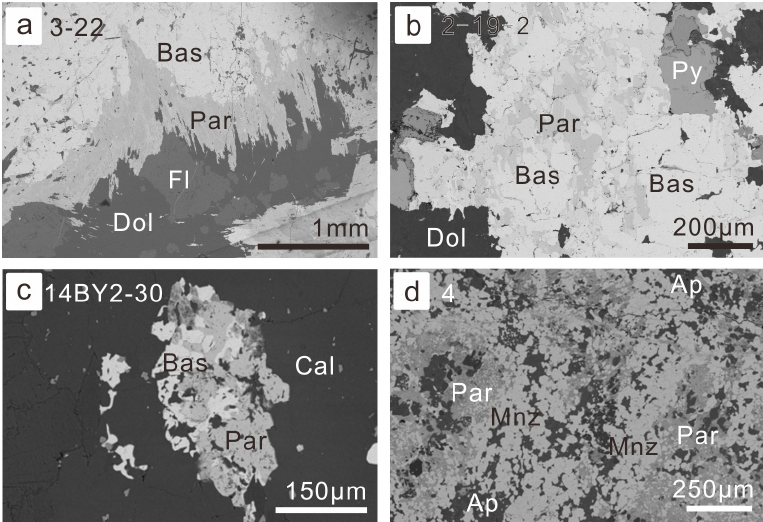
Figure 5. Petrography of replacement of parisite by bastnaesite and monazite: ( a ) bastnaesite megacryst in the vein type of ore with its margin altered into parisite (BSE image for sample 14BY3-22, vein-type of ore); ( b ) bastnaesite was replaced by parisite from the grain boundaries and cleavages within the grains (BSE image for sample 14BY2-19, fluorite-rich altered ore-hosting dolomite); ( c ) bastnaesite grains were almost replaced by parisite (BSE image for sample 14BY2-30, vein-type of ore); ( d ) fine-grained monazite aggregates were altered into parisite from grain boundaries (BSE image for sample BY-4, fluorite-rich REE-Nb ore). Abbreviation of minerals have been listed in former figures, except Par for parisite and Py for